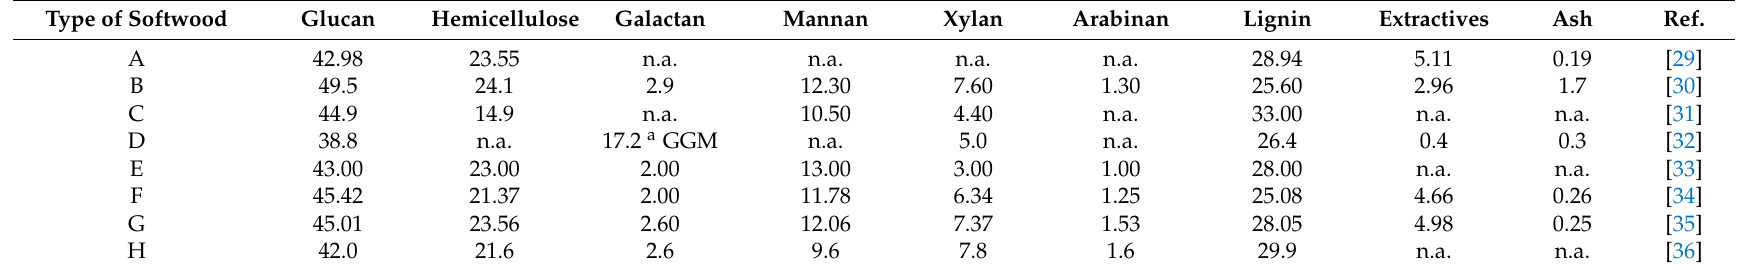
Table 1. Chemical composition of typical softwood lignocellulosic biomass (% on dry weight of biomass). Type of Softwood Glucan Hemicellulose Galactan Mannan Xylan Arabinan Lignin Extractives Ash